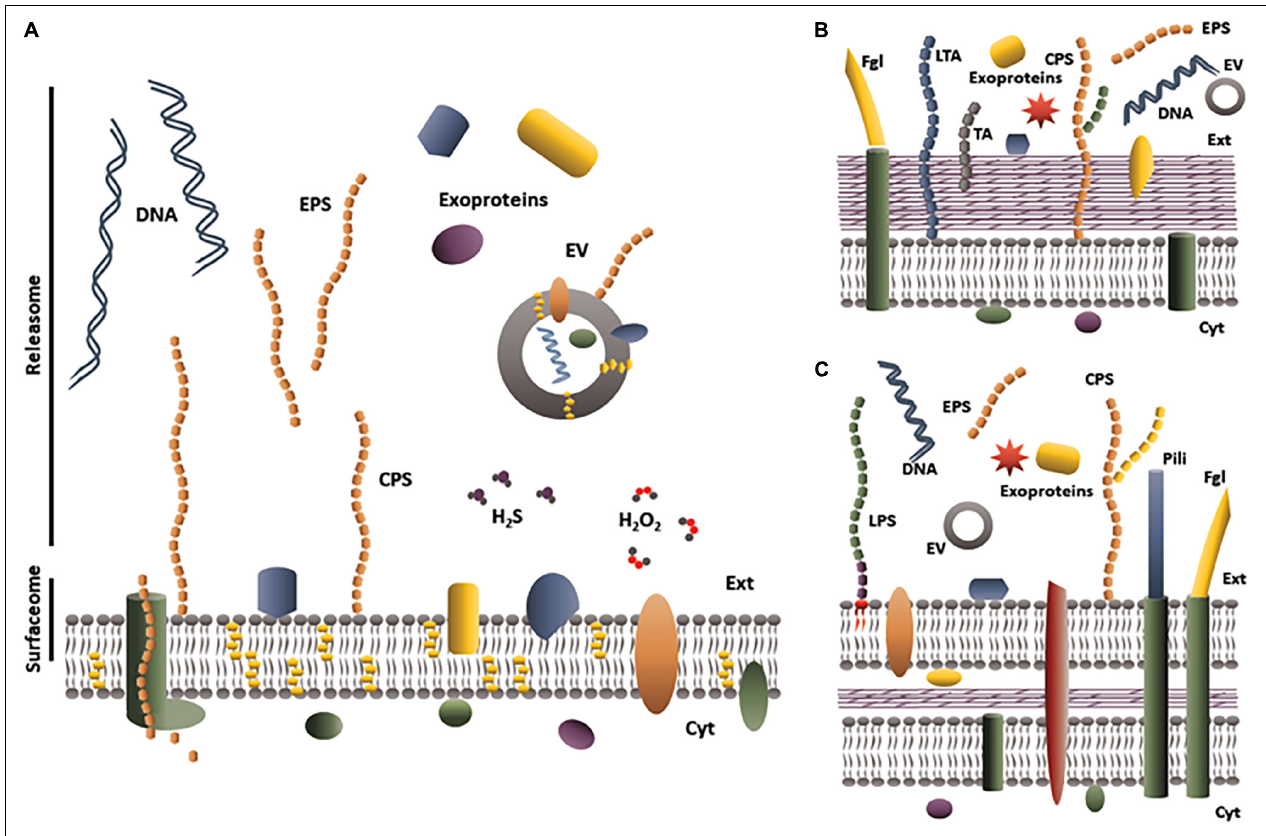
FIGURE 1 | Schematic representation of the releasome of (A) Mycoplasma spp., (B) Gram-positive bacteria, and (C) Gram-negative bacteria. Mycoplasmas are only limited by a cholesterol (yellow hexagons)-rich phospholipid membrane. The cytoplasmic membrane of Gram-positive bacteria is surrounded by a thick peptidoglycan cell wall. In Gram-negative bacteria, the peptidoglycan layer is thin but is surrounded by a phospholipid outer membrane. EV, extracellular vesicles; EPS, exopolysaccharide; Cyt, cytoplasm; Ext, extracellular compartment; CPS, capsular polysaccharide; H 2 O 2 , hydrogen peroxide; H 2 S, hydrogen sulfide; LPS, lipopolysaccharide; LTA, lipoteichoic acid; TA, teichoic acid; Fgl, flagella; DNA, deoxyribonucleic